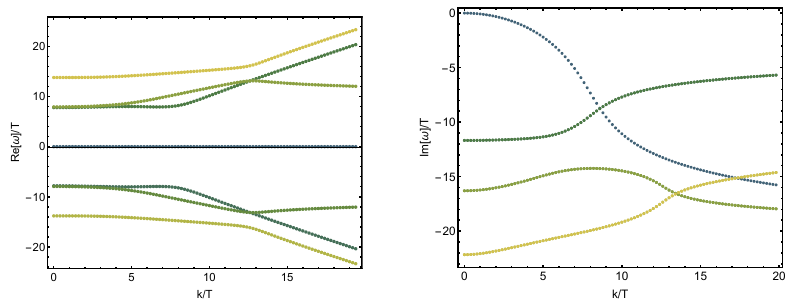
Figure 11 . The higher modes of the transverse spectrum of the model (4.1) for m=T = 0 :